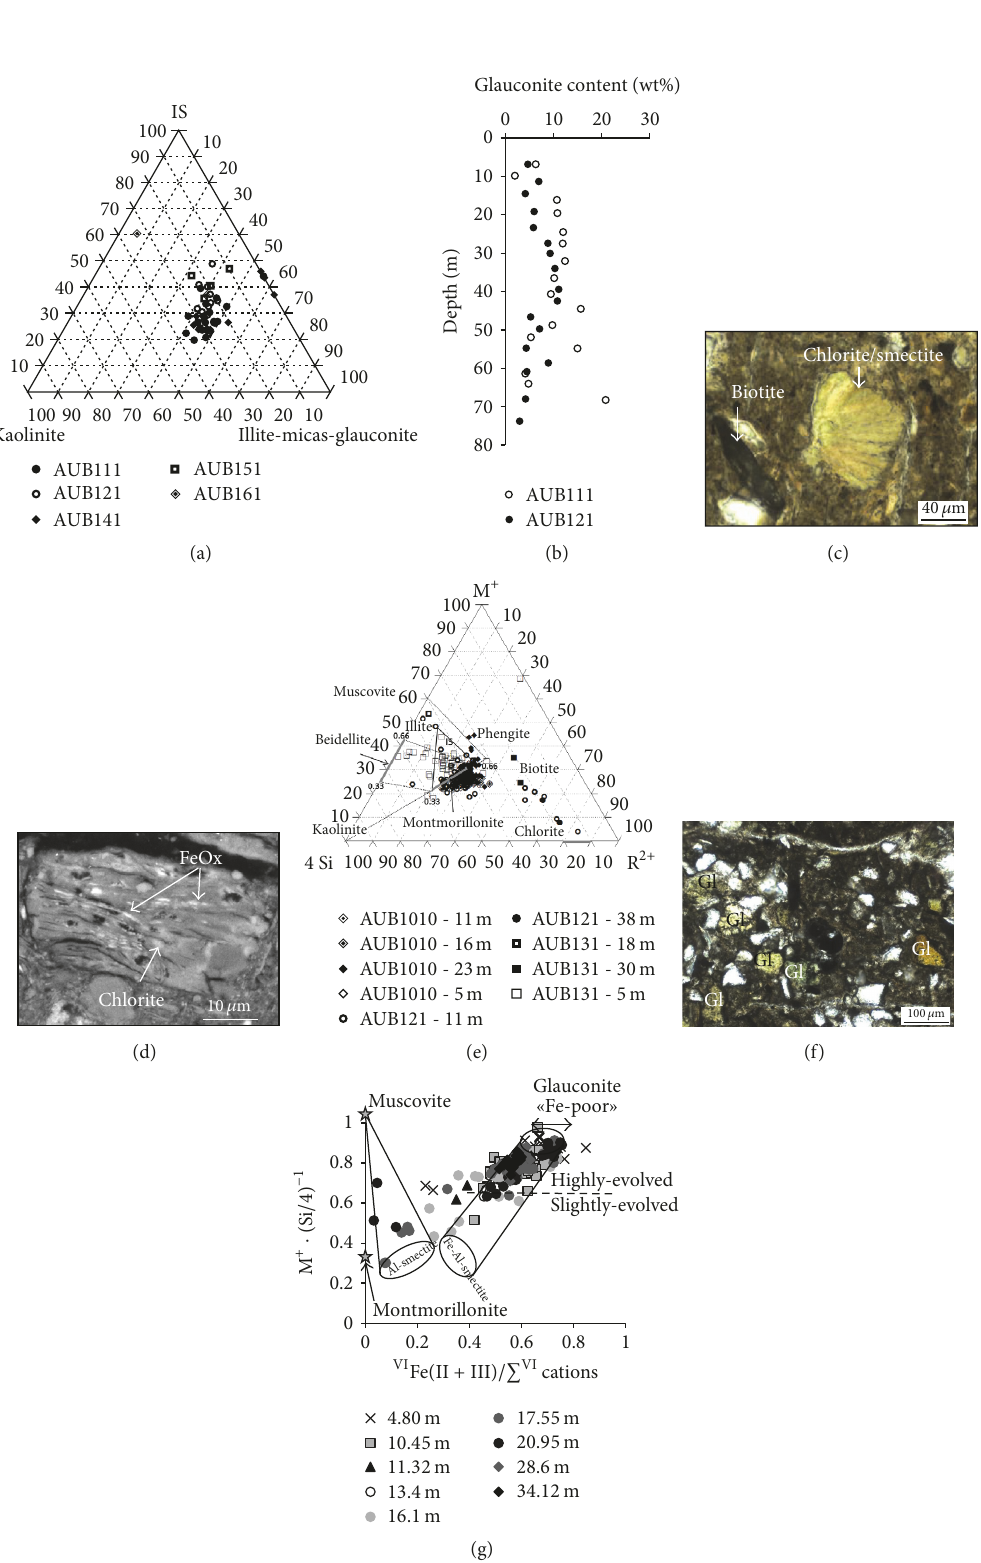
Figure 3: (a) Proportions of the major clay minerals reported in a triangular kaolinite (illite-smectite) mixed layers (noted IS) illite/micas/glauconite. (b) Glauconite content estimated as a function of depth. (c) Chlorite-smectite and biotite flakes (AUB1010-6.63 m) (transmitted light). (d) Chlorite flake with numerous iron hydroxides between the sheets (AUB1010-4.80 m) (BSE image). (e) Electron microprobe analyses of clay minerals of the < 2 𝜇 m fraction that are reported in a 4Si-M + -R 2+ diagram modified from Meunier and Velde [19]. Gray lines indicate the fields of compositions of chlorite, low- (0.33) to high-charge (0.66) beidellites, and of low- (0.33) to high-charge (0.66) montmorillonites. (f) Well-preserved green and brownish oxidized rounded aggregates of glauconite (noted Gl) in sample AUB1010-16.1m (transmitted light). (g) Electron microprobe analyses of glauconite at different depths of the AUB1010 borehole reported in the M + ⋅ (Si/4) −1 versus VI Fe ( II + III )/Σ VI cations diagram indicating compositional domains of glauconite-smectite and illite-smectite according to [20,